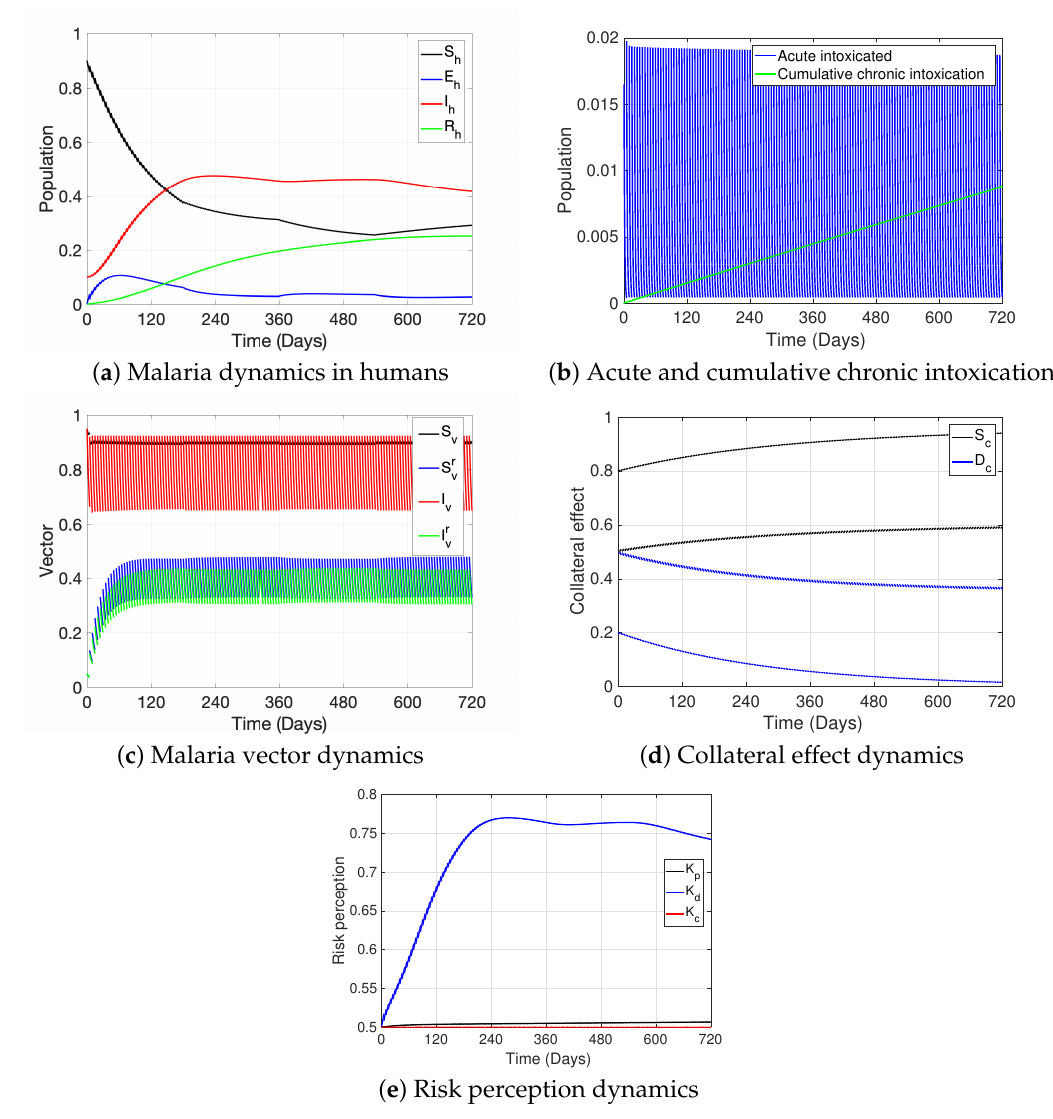
Figure 4. The figure depicts the basic dynamics of the model: ( a ) depicts the behavior over time of the epidemiological classes of malaria in humans; ( b ) shows the point prevalence of acute intoxication cases (blue) and the cumulative chronic intoxication cases (green) over time; ( c ) shows the behavior over time of the epidemiological classes of malaria in mosquitoes; ( d ) de- picts the dynamics of the collateral damage of the ecosystem; and ( e ) shows the risk percep- tion dynamics over time to toxicity of ITNs ( K p ), malaria disease ( K d ), and to collateral damage ( K c ). The parameter values used are the following. For humans: β h ,1 = β h ,2 = 0.022 ∗ ( 1 − η )